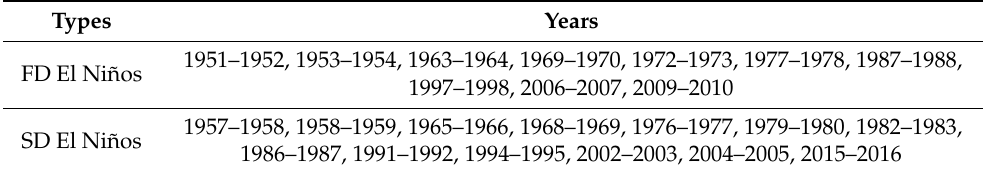
Table 1. The selected fast decaying (FD) El Niño years and slow decaying (SD) El Niño years for the period of